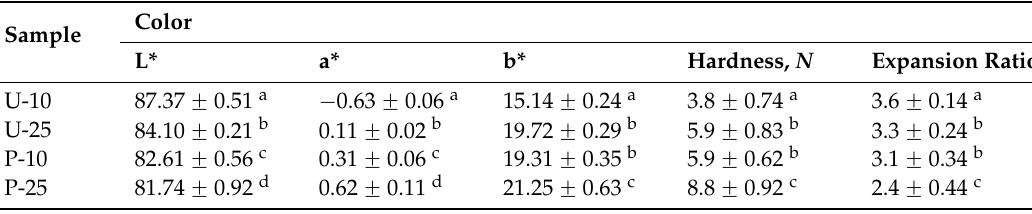
Table 1. Physical characteristics of extruded